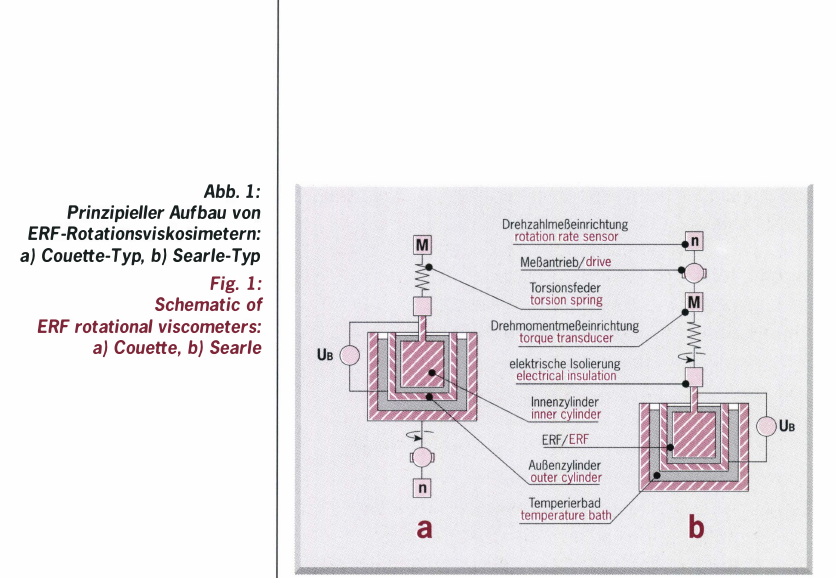
Fig.l: Schematic of ERF rotational viscometers: a) Couette, b) Searle